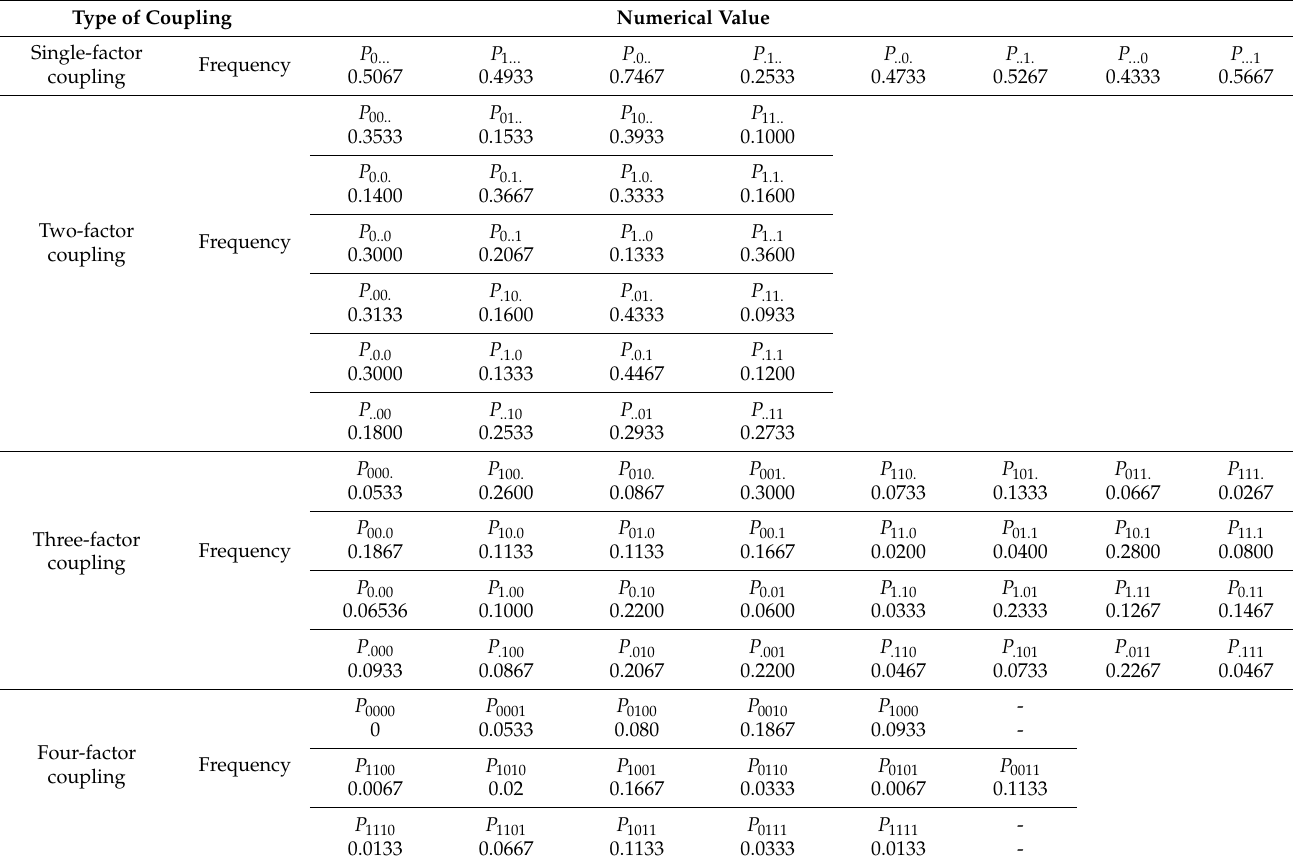
Table 5. Probability of risk coupling of different factors.